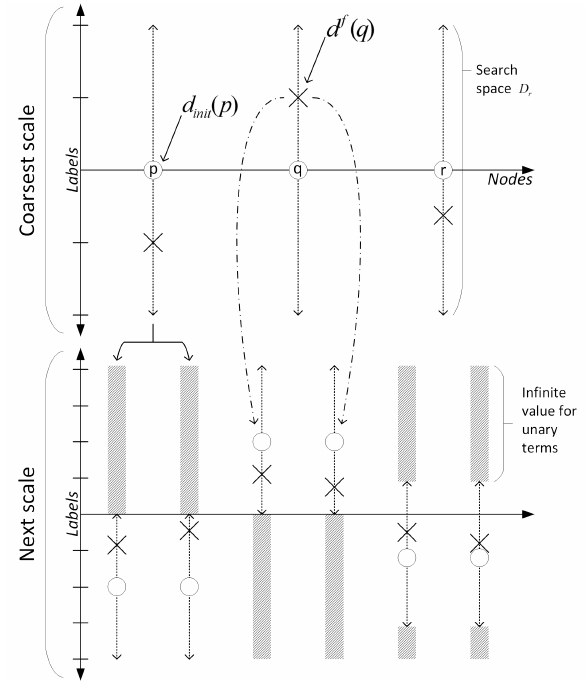
Figure 6: The multiscale approach generates sparsity in the CRF sequence, and only the coarsest CRF is assured to be full. The sparsity is due to defining search space around the previous up sampled scale solution d init